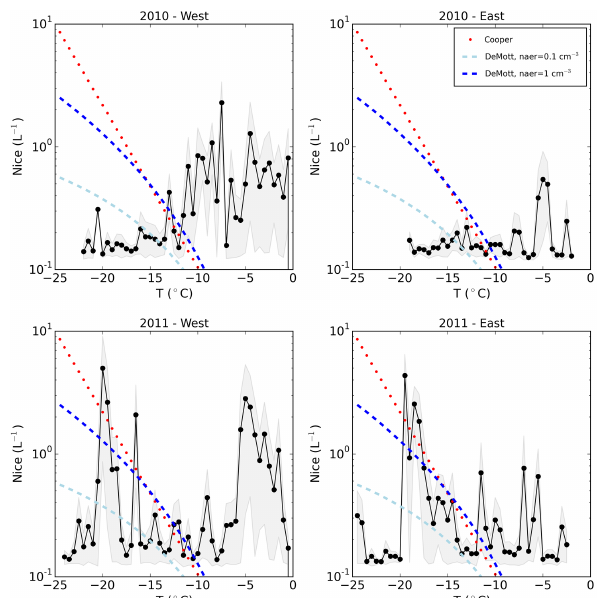
Figure 10. Distribution of ice crystals (L − 1 ) as a function of atmo- spheric temperatures for 2010 (top row) and 2011 (bottom row), for the western side (left column) and for eastern side (right column). The median of the number concentrations was derived per 0.5 ◦ C bins. The dotted and dashed lines show the predicted number of pri- mary ice particles from two parameterization schemes (see text for details). The shaded area represents the median absolute deviation from the median value. West refers to 74–67 ◦ W, and east refers to 65–60 ◦